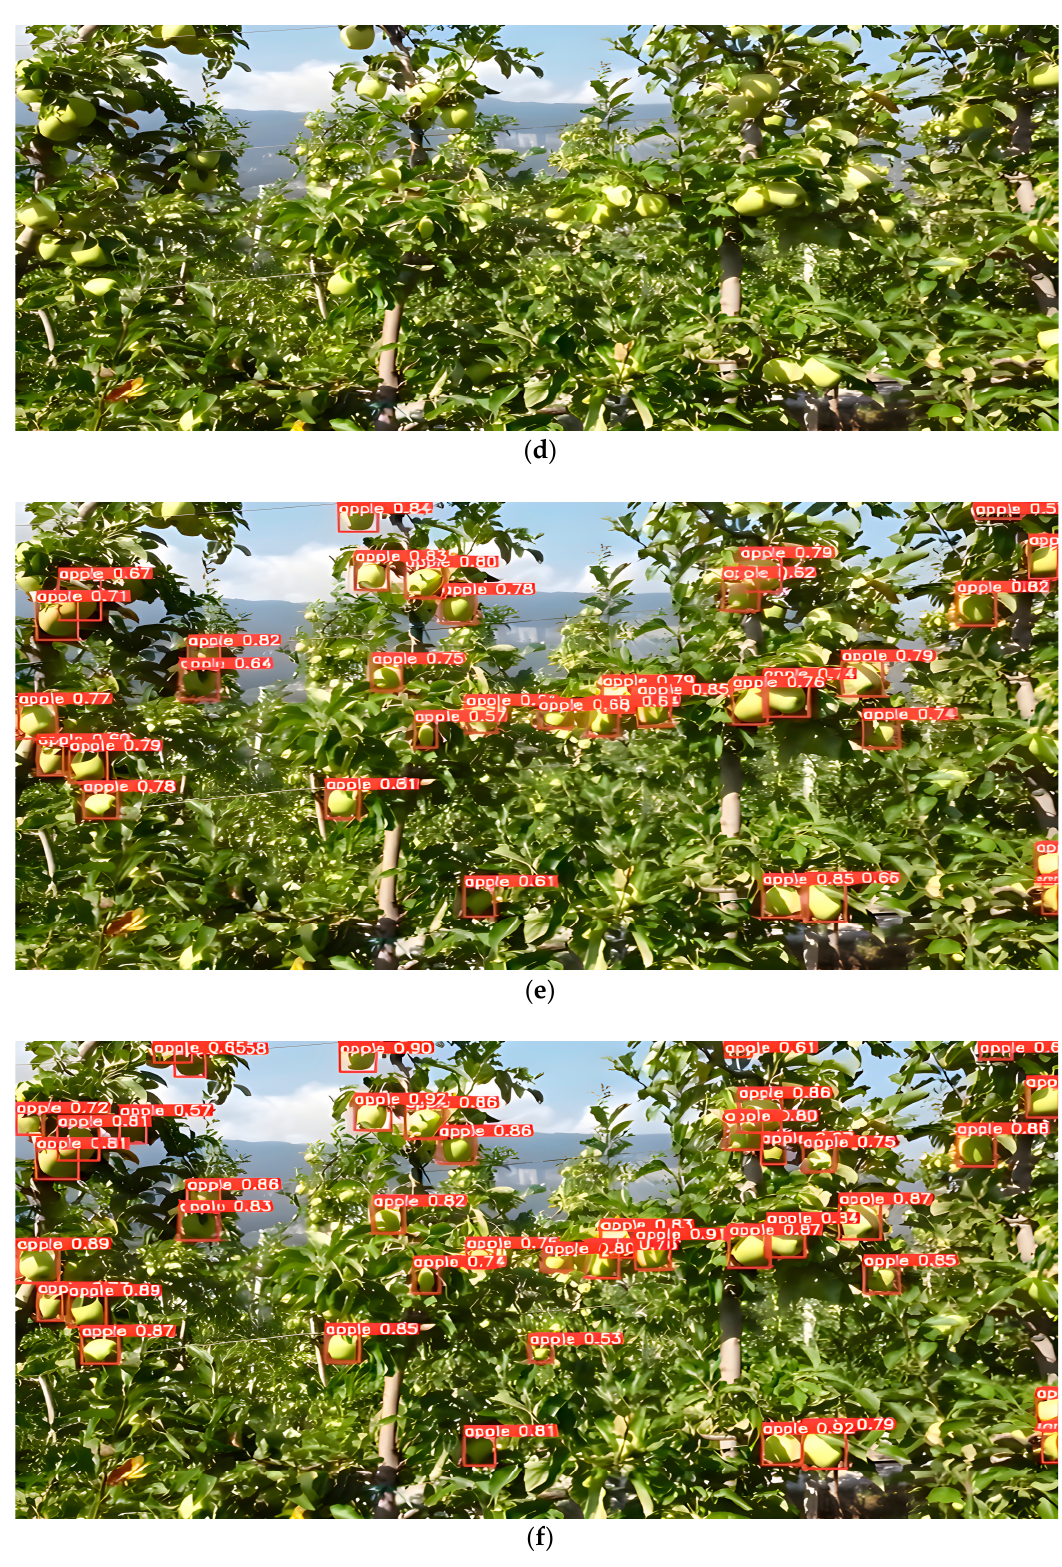
Figure 10. Apple (gold delicious) detection outcome for normal images; ( a ) apple (gold delicious) original image 1 (frame 11640); ( b ) apple (gold delicious) detection by original Yolov5; ( c ) apple (gold delicious) detection by proposed Yolov5; ( d ) apple (gold delicious) original image 2 (frame 12237); ( e ) apple (gold delicious) detection by original Yolov5; ( f ) apple (gold delicious) detection by proposed Yolov5.